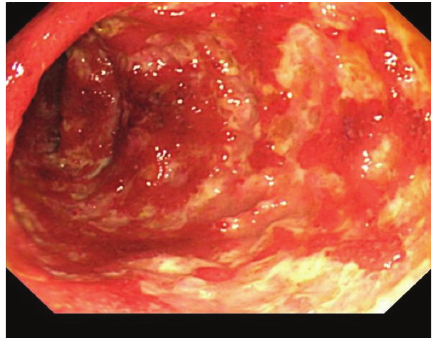
Figure 3: Colonoscopy findings in a 36-year-old man with RP who presented with bloody diarrhea five years after the initial diagnosis ofRP.Multiplecircular and longitudinalulcers anderosionsareseen in the descending colon. RP, relapsing polychondritis.